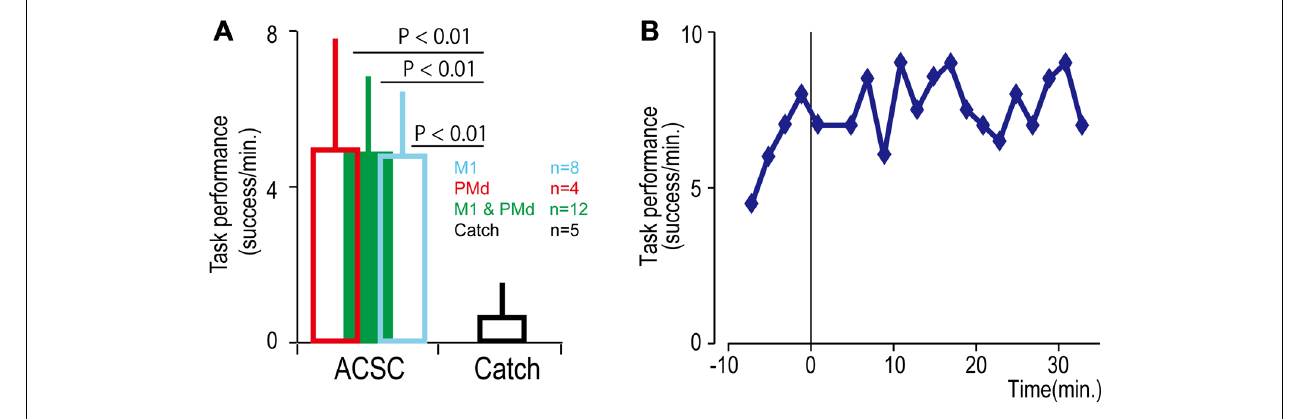
Before time zero the monkey was required to control the cursor with LFP activity. After time zero the task involved ACSC, using the same cortical electrode in digit area of